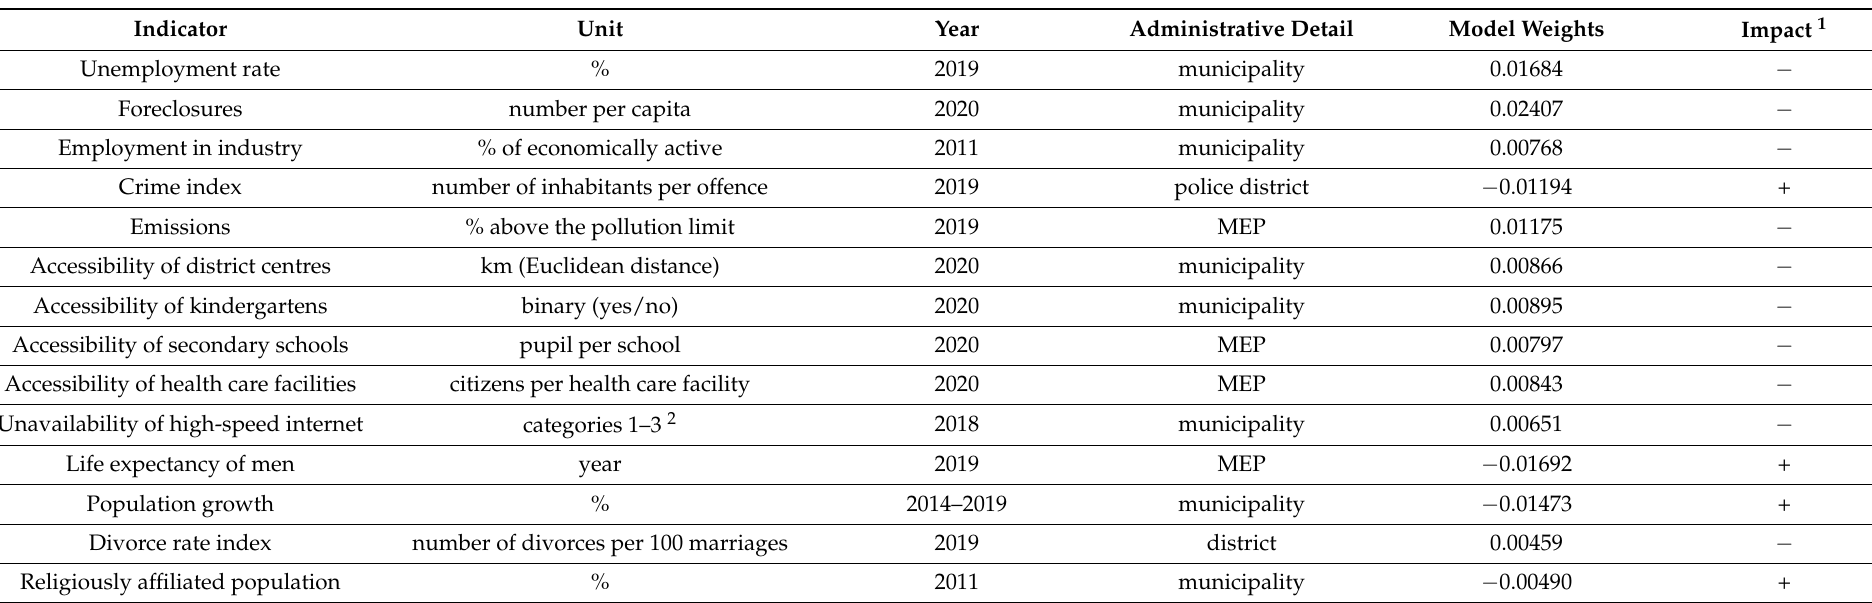
Table A1. Input indicators of the original index according to the Median and Aspen Institute study: the definition of input indicators remains unchanged, they have been updated to the most temporally available